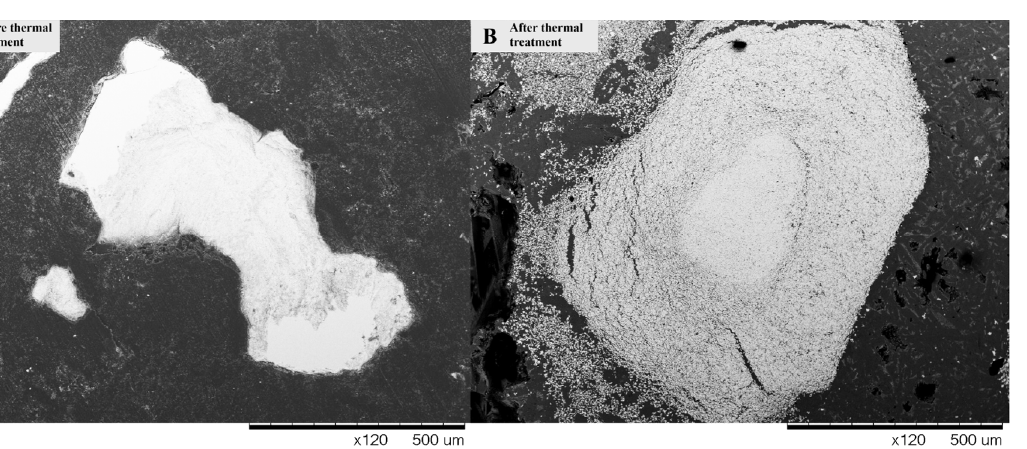
Figure 1. Crushed WC-Co particles (710–1000 µm) before ( A ) and after ( B ) thermal treatment at 1280 °C temperature.